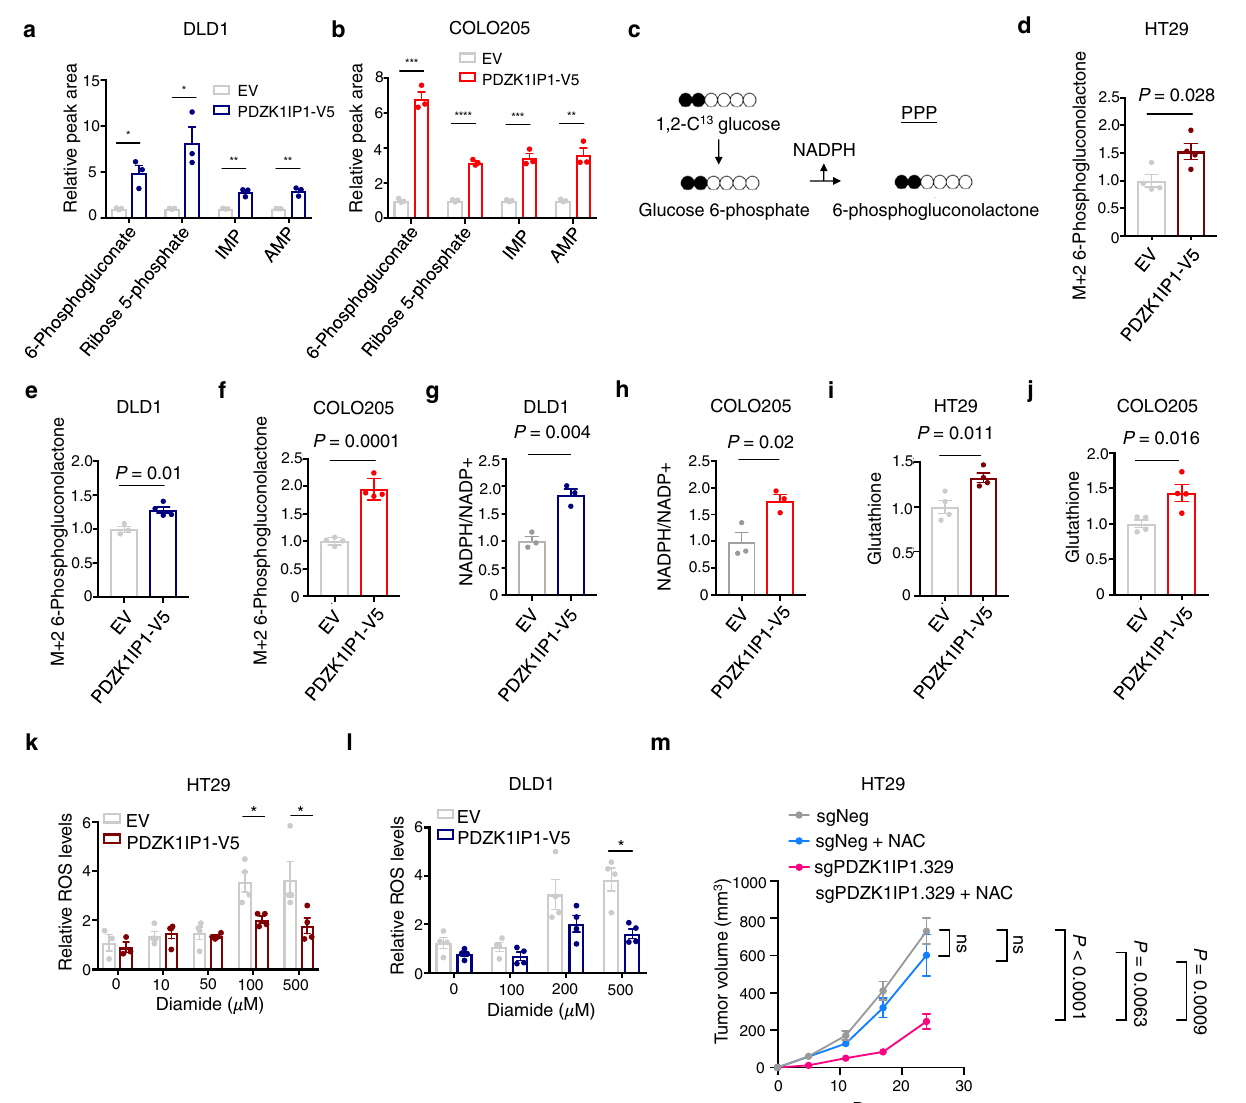
Fig.7| PDZK1IP1 regulatescancermetabolism.a , b Steadystatelevels(totalpeak are) of PPP intermediates and downstream metabolites ( n =3 per group). Data presentedasmean ± s.e.m.Signi fi cancewasdeterminedusingtwo-sidedStudent ’ s t test. * P <0.05, ** P <0.01, *** P <0.001, **** P <0.0001. c Schematic of PPP entry fromglycolysis. d – f Totalpeakareaoflabeled6-phosphogluconolactone( n =4per group), 1,2C 13 -glucose tracing. Data presented as mean ± s.e.m. Signi fi cance was determined using two-sided Student ’ s t test. g , h Steady-state NADPH/NADP+ ratios from total metabolite peak area ( n =3 per group). Data presented as mean ± s.e.m. Signi fi cance was determined using two-sided Student ’ s t test. i , j Steady-